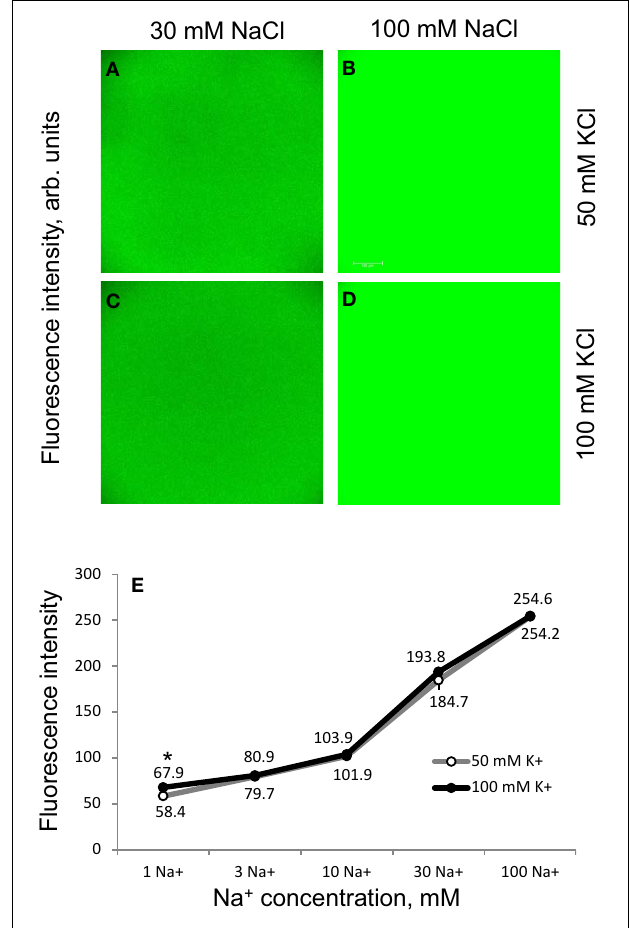
FIGURE 4 | Methodological aspects of CoroNa Green dye calibration. CoroNa Green dye was calibrated in vitro in a buffer solution containing different Na + and K + concentrations. (A–D) In vitro fluorescence images for two Na + and two K + concentrations used in experiment. One (of four) representative images is shown for each Na + and K + concentration; (E) dose-dependency of Na + fluorescence signals at 50 and 100mM KCl background. Mean ± SE ( n = 60; four images, 15 replicates recorded from each image). Asterisk indicates a significant (at P < 0 . 05) difference between K + treatments. Please note that in most cases the error bar is smaller than the symbol per se